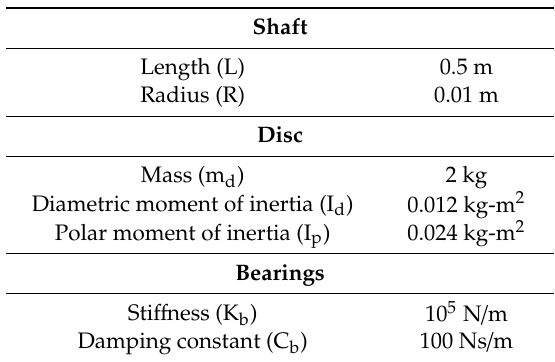
Table 4. The specifications of the disc, shaft and